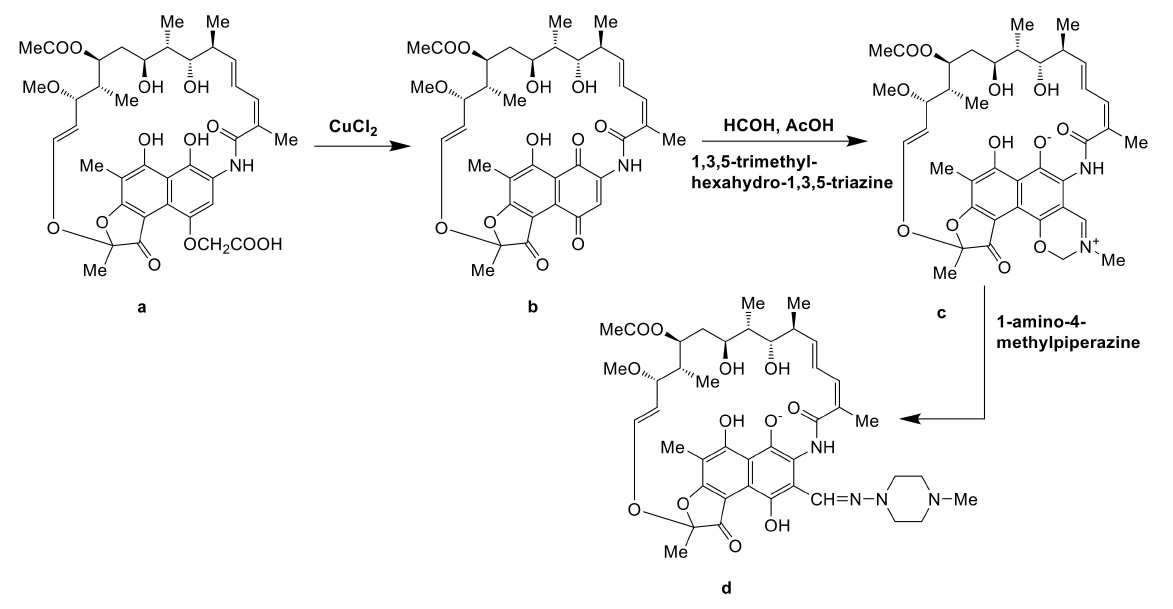
Figure 14. The semi-synthesis pathway of 24-desmethylrifampicin [86,87].